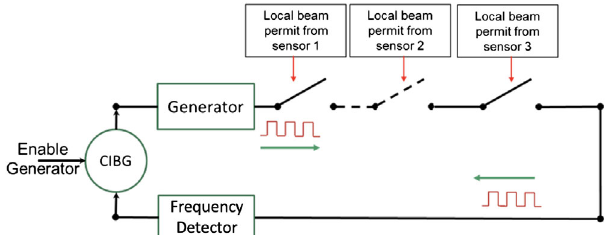
FIG. 2. The closed-loop principle for beam permit loop with several sensors (shown in open